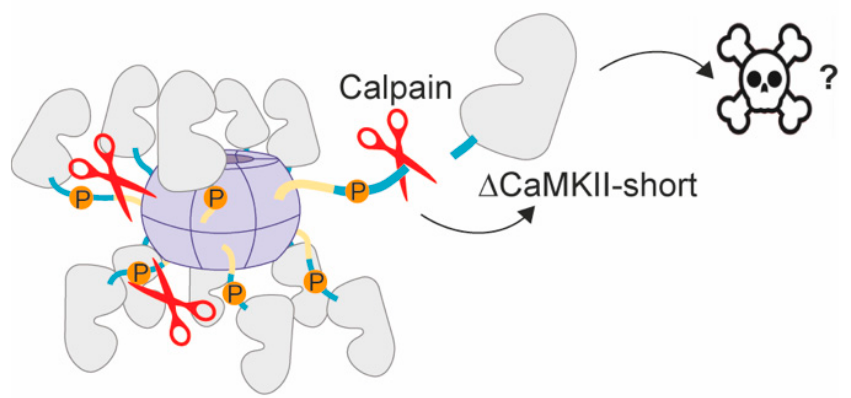
Figure 4. CaMKII cleavage by calpain after ischemia [113]. Ischemic conditions lead to overactivation of calpains (red scissors) as well as increased Thr286/287 CaMKII autophosphorylation, facilitating cleavage of CaMKII by overactivated calpains at M 281 ↓ H 282 . This leads to the ischemia-specific expression of ∆ CaMKII consisting of the kinase domain and the N-terminal end of the regulatory domain, which is devoid of the Thr286/287 and CaM-binding region responsible for autoinhibition of the